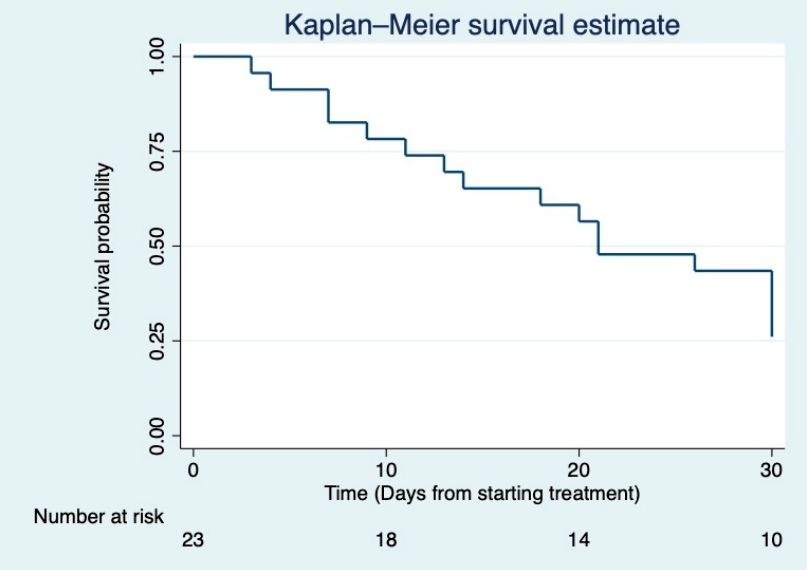
Figure 1. Survival curve showing overall 30-day mortality in COVID-19 patients with ventilator- associated pneumonia due to difficult-to-treat non-fermenter gram-negative bacteria.